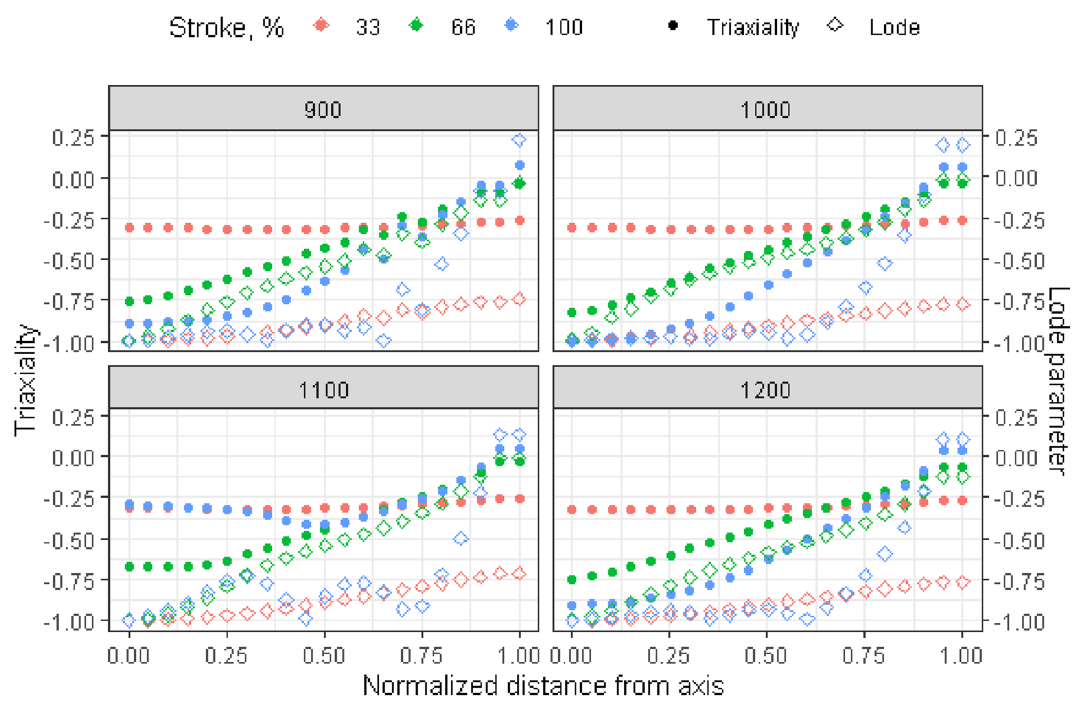
Fig. 11 Lode parameter and triaxiality factor for the equator line in three compression stages for a nominal strain rate of 30 1/s